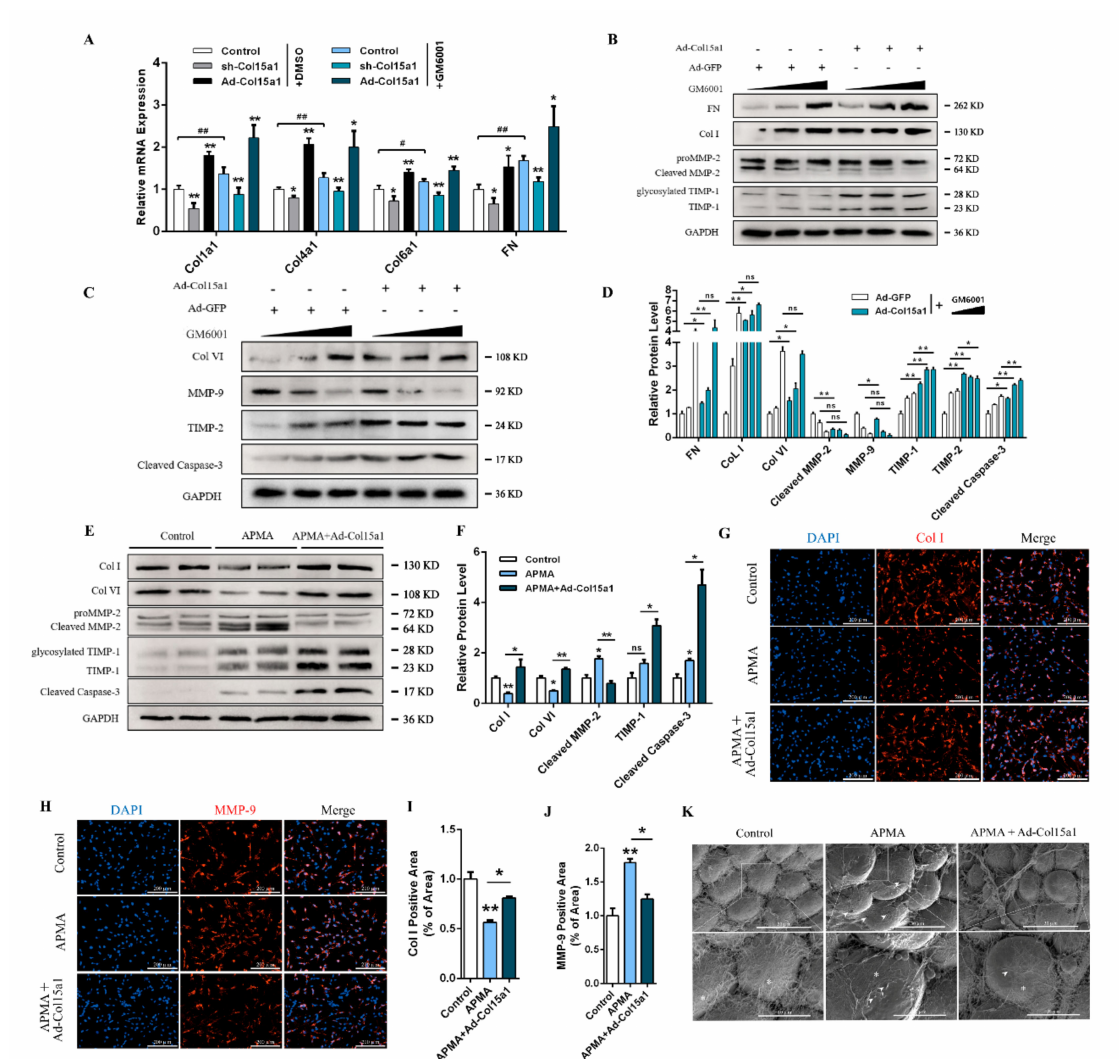
Figure 5. ColXV induced ECM remodeling dependent on MMPs. All mice were pretreated with either Ad-GFP or Ad-Col15a1. ( A ) Relative mRNA expressions of Col1a1, Col4a1, Col6a1 and Fibronectin in mice inguinal white adipose tissue (iWAT) with or without GM6001 ( n = 6). ( B – D ) Relative protein expressions of Fibronectin, Col I, Col VI, MMP-2, MMP-9, TIMP-1, TIMP-2 and Cleaved Caspase-3 in mice iWAT with gradients concentration of GM6001 ( n = 6). (E-F) Relative protein expressions of Col I, Col VI, MMP-2, TIMP-1 and TIMP-2 in the Control group, APMA group and co-treatment of Ad-Col15a1 and APMA group in mice iWAT ( n = 6), each group has two technical repeats ( E ). ( G – J ) Representative images of Col I and MMP-9 in adipocytes by immunofluorescent staining in di ff erent groups ( n = 4). ( K ) Representative images of collagen bundles microstructure on adipocytes surface by scanning electron microscope. Scale bar, 30 µ m (top) and 10 µ m (bottom) ( n = 4). Arrowheads indicate disrupted collagen fibers and exposed adipocytes surface (middle). Asterisks indicate adipocytes. Values are presented as mean ± SEM. * p < 0.05, ** p < 0.01, ns, not